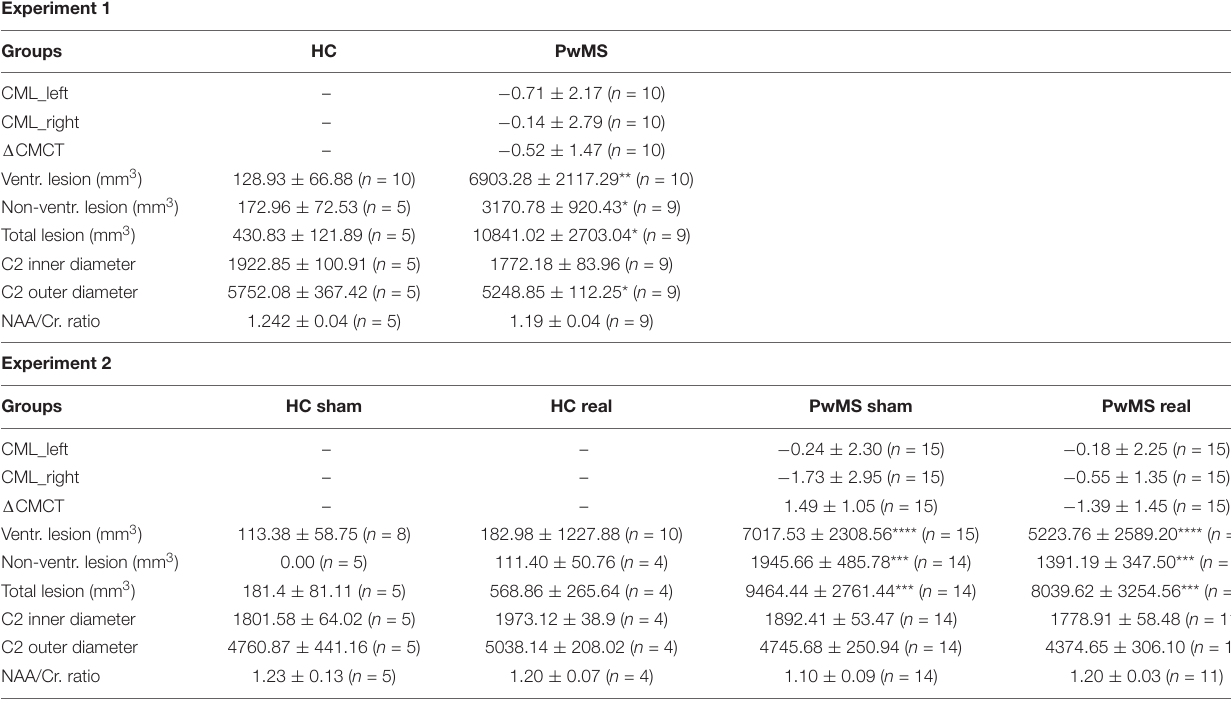
TABLE 1 | CNS injury was evaluated using the central motor latency (CML) of lower limb and MRI measures. Experiment